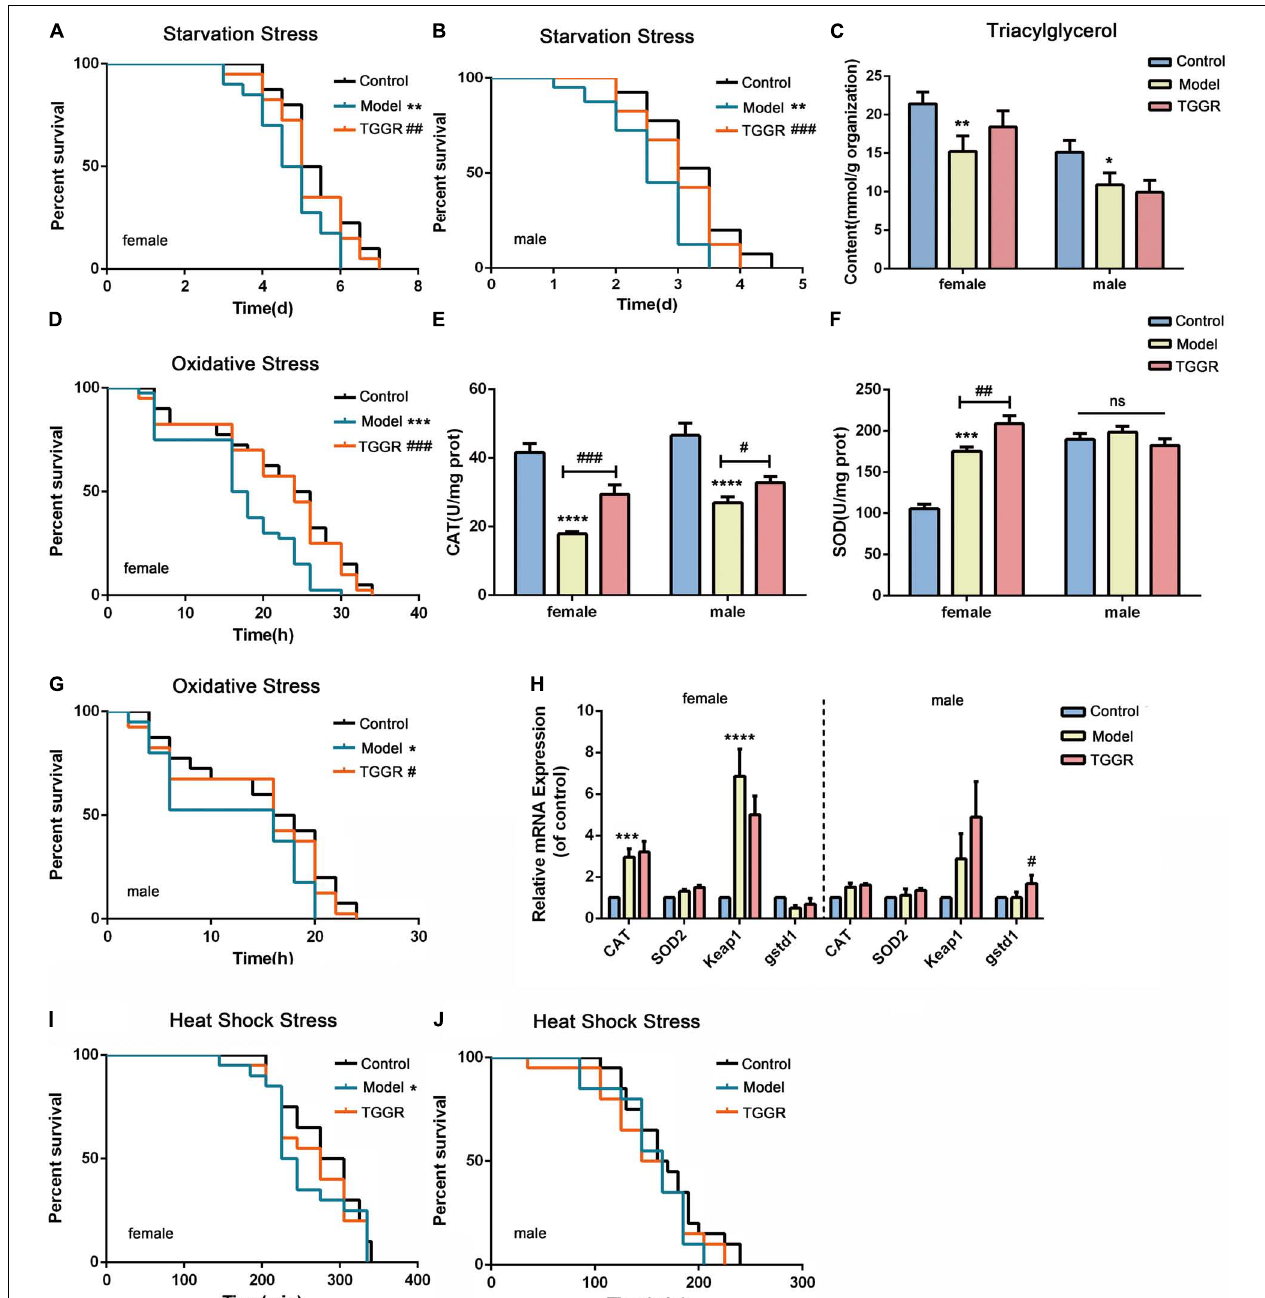
FIGURE 5 | Effect of TGGR on stress resistance in Drosophila . Survival of flies under starvation stress ( A , female; B , male), oxidative stress ( D , female; G , male), and heat-shock stress ( I , female; J , male) with or without TGGR treatment ( N = 30 flies in per condition, two-tailed unpaired t -test). TAG levels in flies with or without TGGR treatment (C) ; Enzyme activity of Cat (E) or SOD (F) with or without TGGR treatment; Analysis of anti-oxidant gene expression in flies by qRT-PCR with or without TGGR treatment ( H: the left side of the dotted line indicates females and the right side, males) ( N = 60 flies, two-tailed unpaired t -test). “Control” was 7-day-old flies, “Model” was 40-day-old flies, and “TGGR” was 40-day-old flies with TGGR (5 mg/mL) treatment. * p < 0.05, ** p < 0.01, *** p < 0.001, **** p < 0.0001 vs. the control; # p < 0.05, ## p < 0.01, ### p < 0.001 vs. the model.